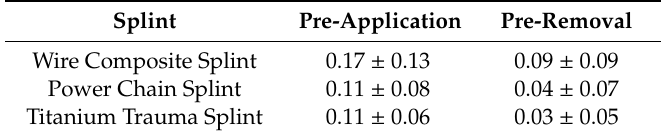
Table 8. Sulcus Bleeding Index (SBI) values pre-application and pre-removal of the